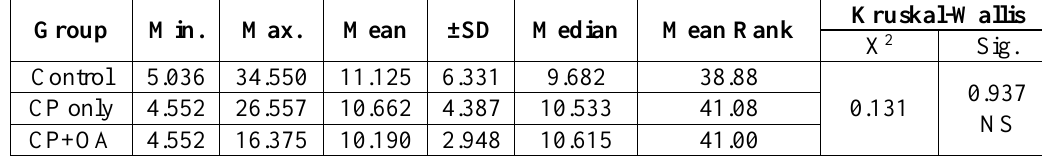
Table 3: Illustrates the analytic test of TNFα.